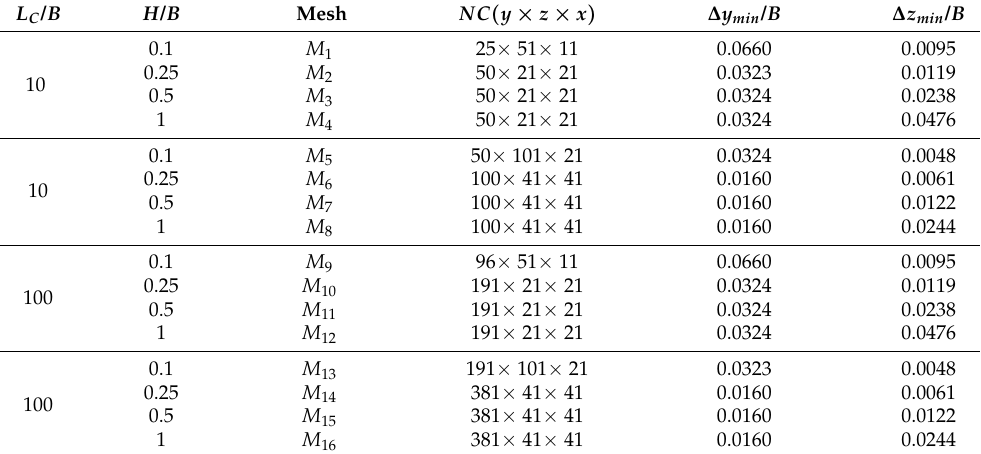
Table 2. Details of the channel meshes used in the accuracy